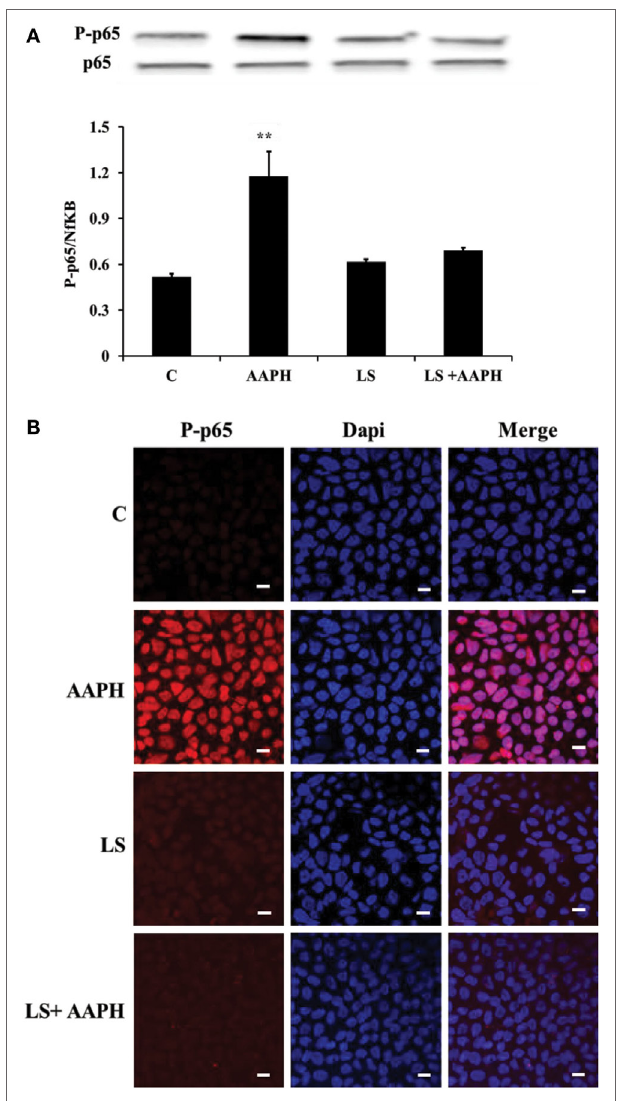
FigUre 2 | Inhibition of AAPH-induced inflammatory signaling pathways by Lactobacillus casei Shirota (LS) in human colon carcinoma cell line/TC7 cells. Cells differentiated on transwell filters were untreated (C), treated with AAPH (AAPH) treated with LS or pretreated with LS for 1.5 h, and then treated with AAPH (LS + AAPH) for 2.5 h. Western blot densitometric values of phosphorylated p65 were normalized with un-phosphorylated p65 (a) . Values represent mean ± SD of three independent experiments, carried out in triplicate. ** P < 0.01 immunolocalization of P-p65 (B) was performed by confocal microscopy, in order to evaluate its translocation into the nucleus. For P-p65 immunofluorescence analysis, cells were labeled with specific primary antibodies against P-p65 and subsequently with tetramethylrhodamine isothiocyanate secondary antibodies, while nuclei were stained in blue (DAPI). Each figure is representative of three independent assays (63 ×